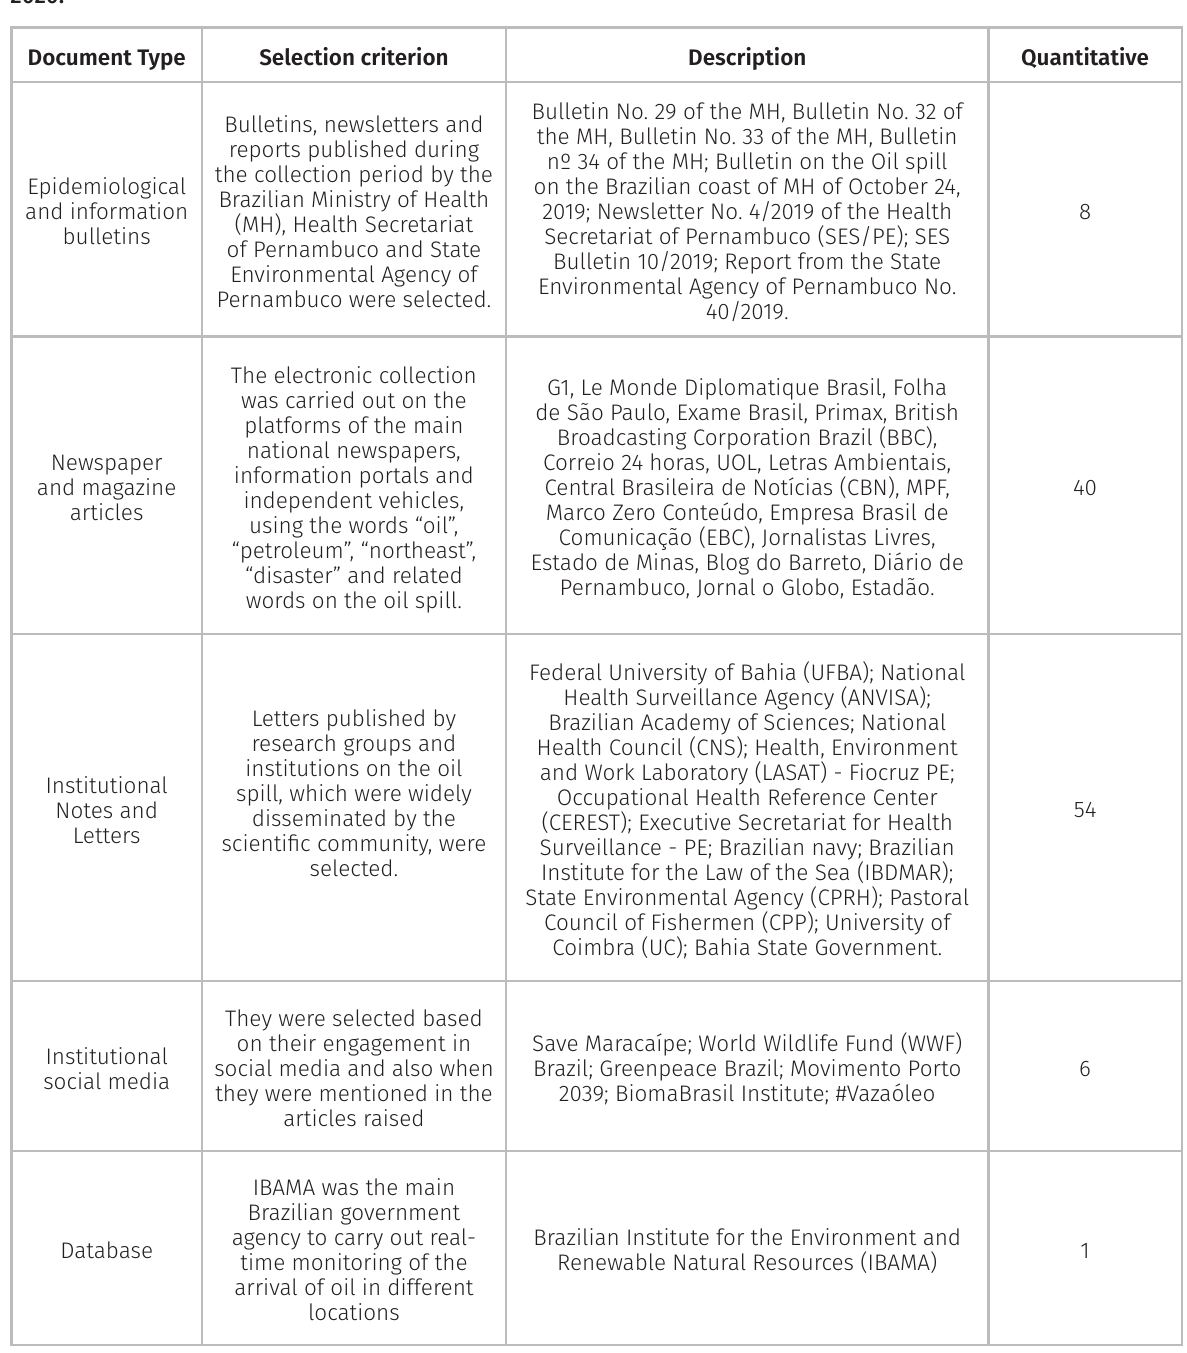
Table I. Survey of documents on the oil spill on the coast of Northeast Brazil, between September 2019 and June